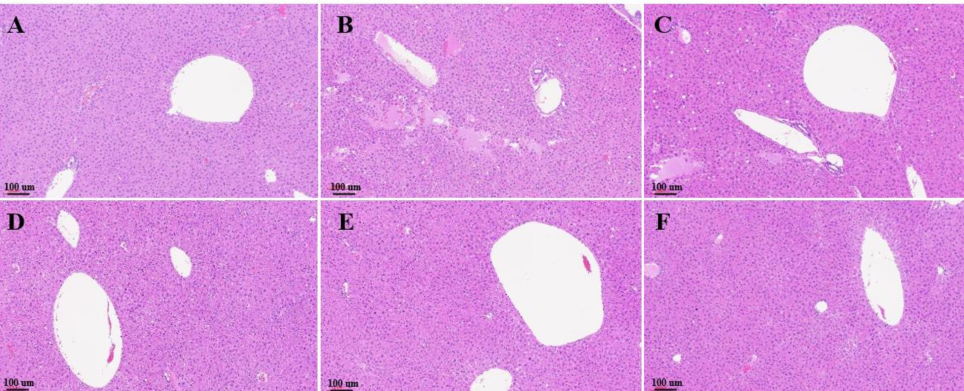
Figure 6. Liver morphometry. EtOH-induced liver damage model mice were orally administered with ( A ) vehicle (saline, normal group), ( B ) control group, ( C ) 1.03, ( D ) 3.08, ( E ) 9.23 mg/kg BW of EPPH, respectively, and ( F ) 200 mg silymarin/kg BW as positive control on a daily basis. After 42 days of treatment, liver morphometry was measured by hematoxylin and eosin staining. Hepatic steatosis is induced in mice exposed to EtOH. Magnification = × 10.